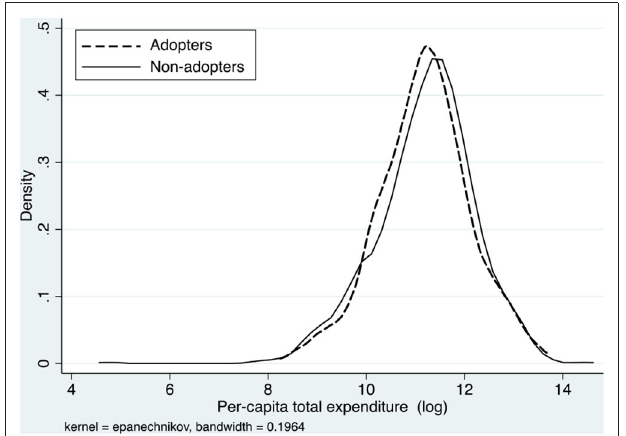
FIGURE 4 | Kernel density distribution of the log of per-capita food expenditure of adopters and non-adopters of organic fertilizers.